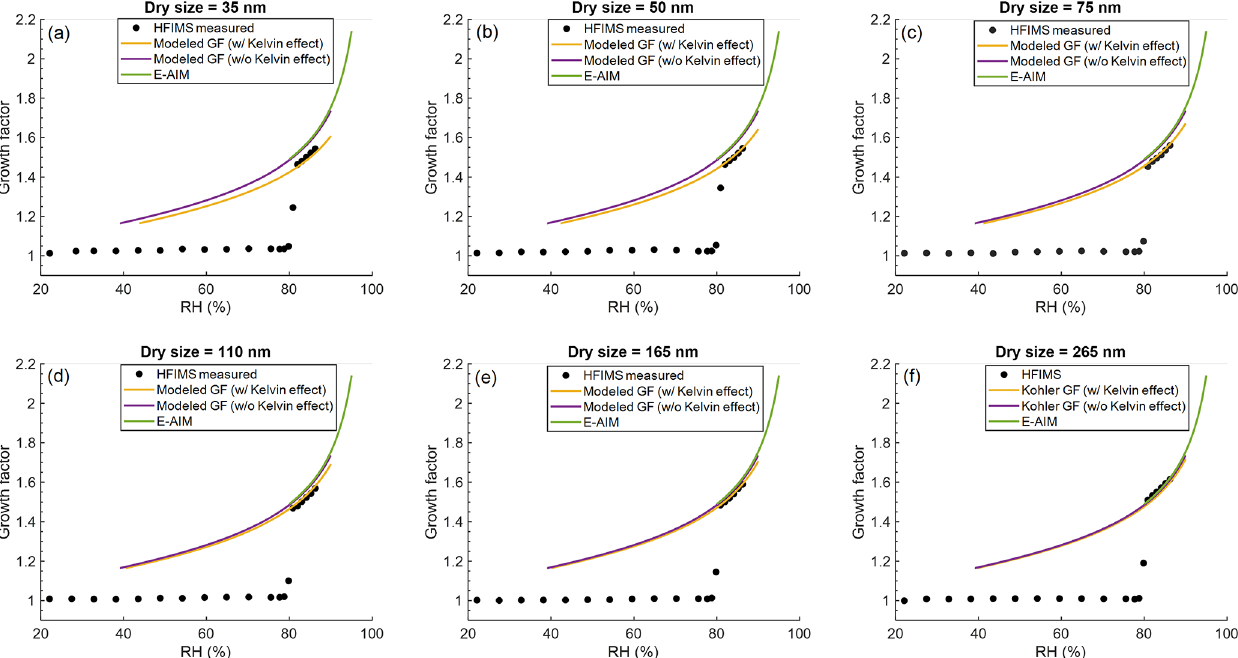
Figure 4. Hygroscopic growth curves of ammonium sulfate particles for six DMA-selected sizes (35, 50, 75, 110, 165, and 265nm). Black circles present growth factor derived from HFIMS measurements. Solid lines are model predictions of the growth factor curves with and without Kevin effects and calculated from E-AIM